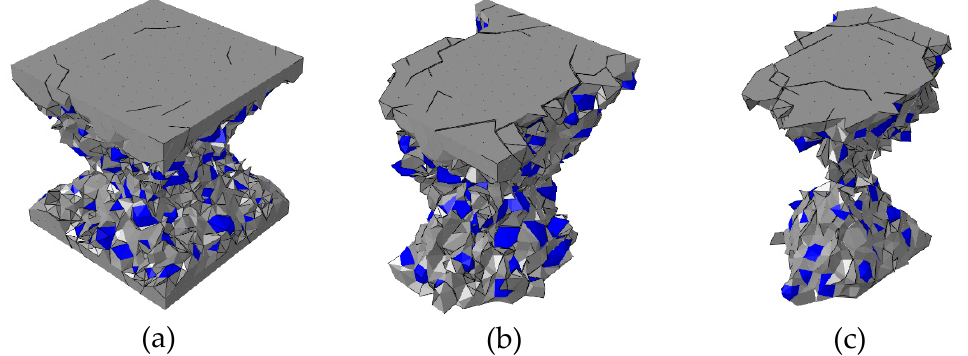
Figure 16. The residual part of the concrete specimen at different loading states in Figure 13: ( a ) state B, ( b ) state C, ( c ) state D.